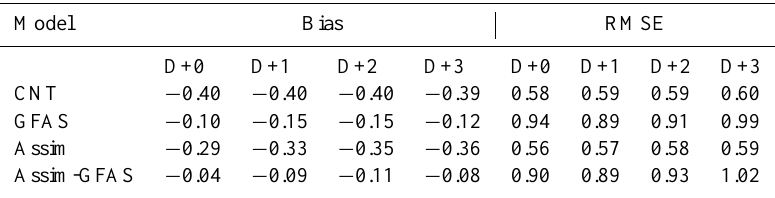
Table 11. Mean bias and RMSE of modeled tropospheric NO 2 columns (units 10 15 molec cm − 2 ), compared to SCIAMACHY observations over western Russia between 20 July and 15 August, as function of the hindcast day. Model Bias RMSE